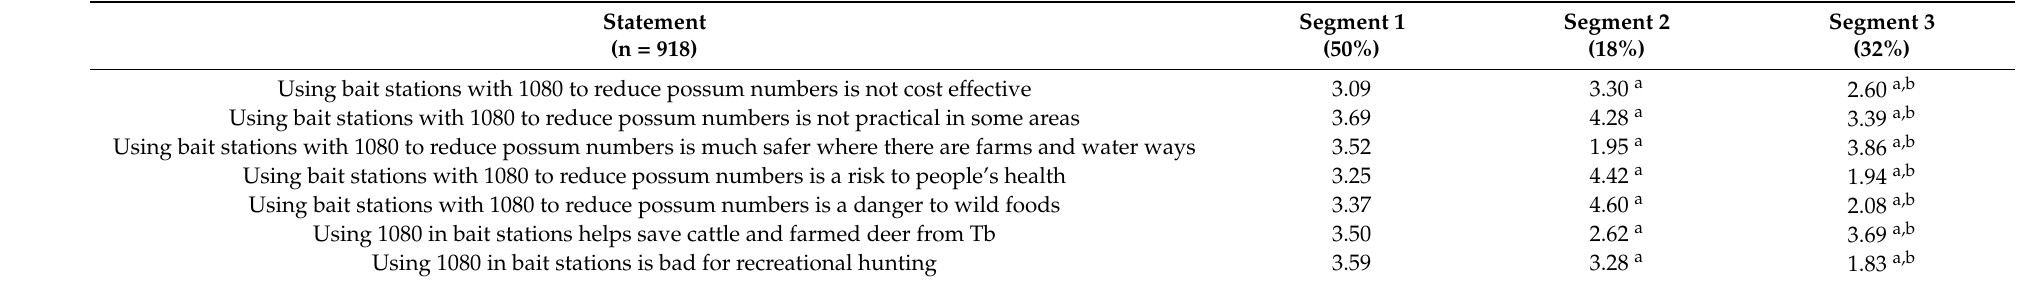
Table 4. Belief segments about ground baiting with 1080.